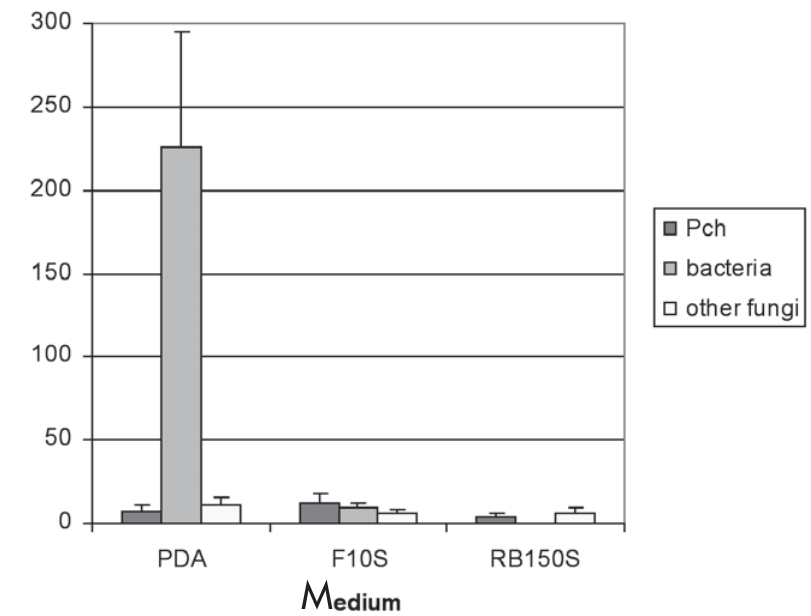
Fig. 1. Colony-forming units (CFUs) of Phaeomoniella chlamydospora , bacteria and saprobic fungi per Petri dish, grown on three culture media (PDA, F10S and RB150S) after inoculation with soil suspensions and incubation at 25ºC in darkness for 20 days. Data given are the means of 54 replicates. Bars represent standard errors.